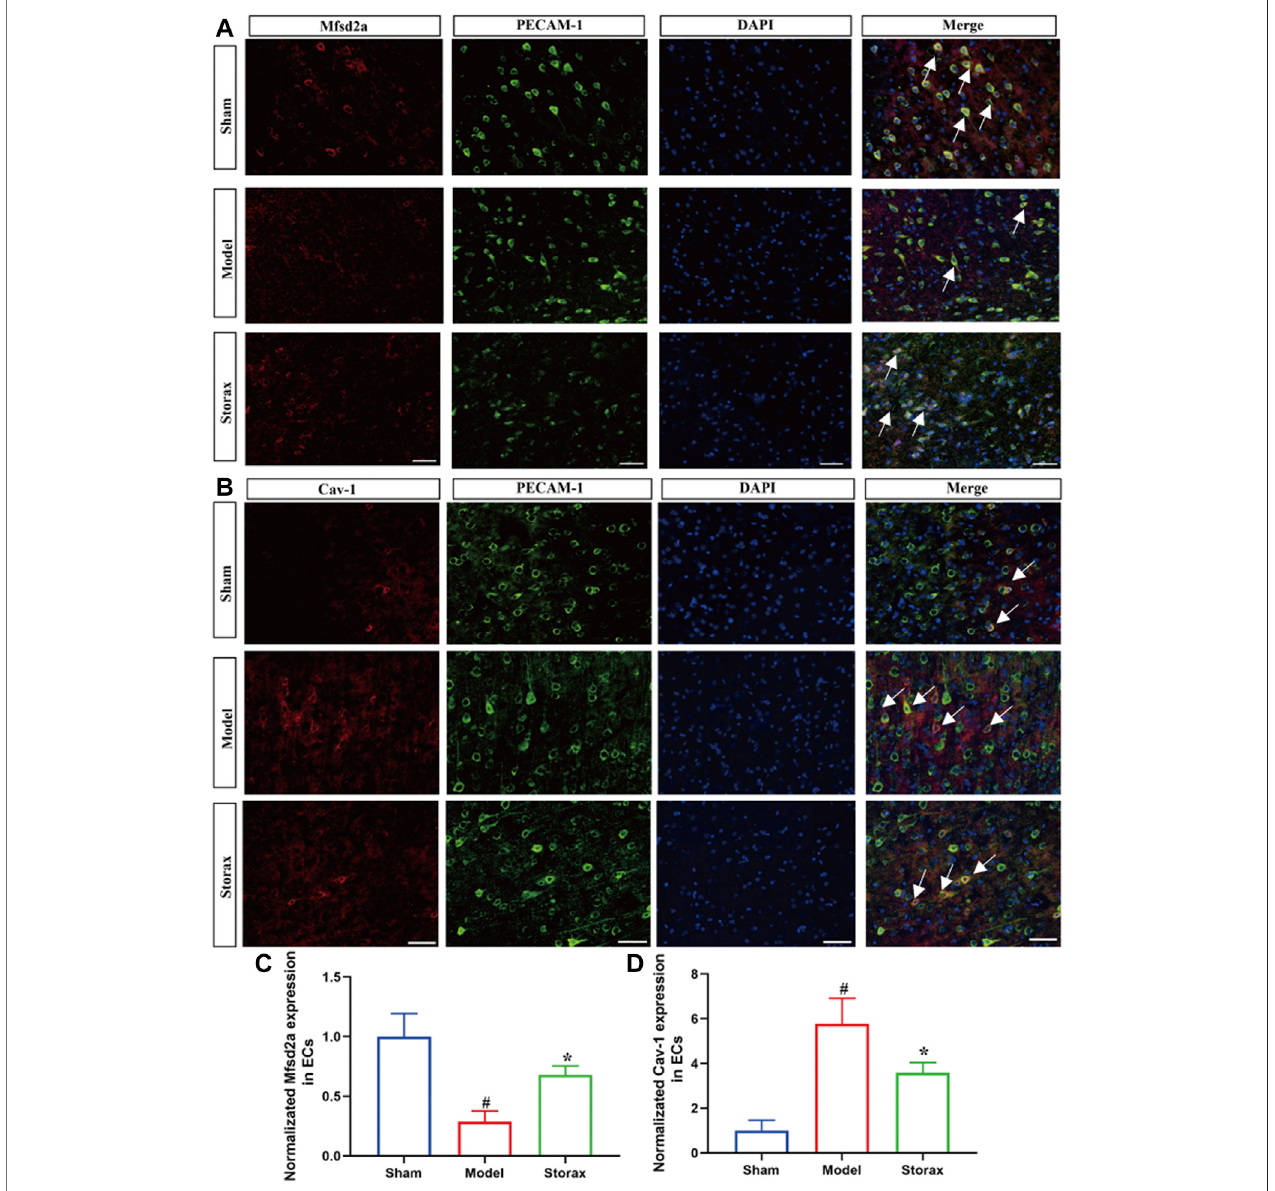
FIGURE 5 | Effects of Storax on Mfsd2a and Cav-1 in ECs at 6 h after stroke. (A) Representative immuno fl uorescence images of Mfsd2a and PECAM-1. (B) Representative immuno fl uorescence images of Cav-1 and PECAM-1. (C,D) Quantitative data of the fl uorescence intensity of Mfsd2a and Cav-1. Data were shown as the mean ± SEM. ## p < 0.01, ### p < 0.001 vs . Control group, * p < 0.05, ** p < 0.01 vs . Storax group, bar = 50 μ m, n =